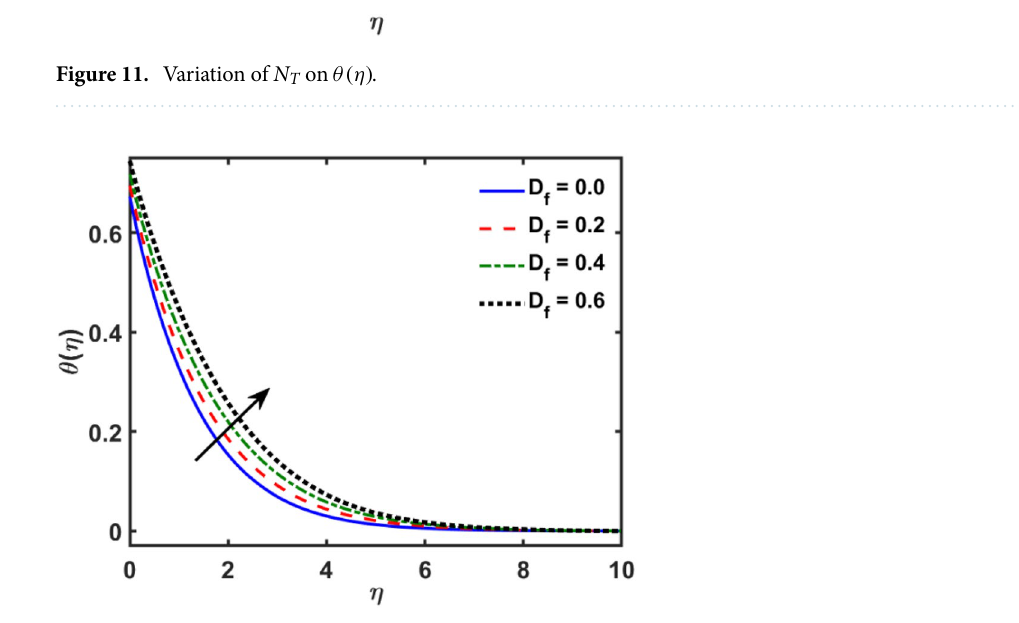
Figure 12. Variation of D f on θ(η)